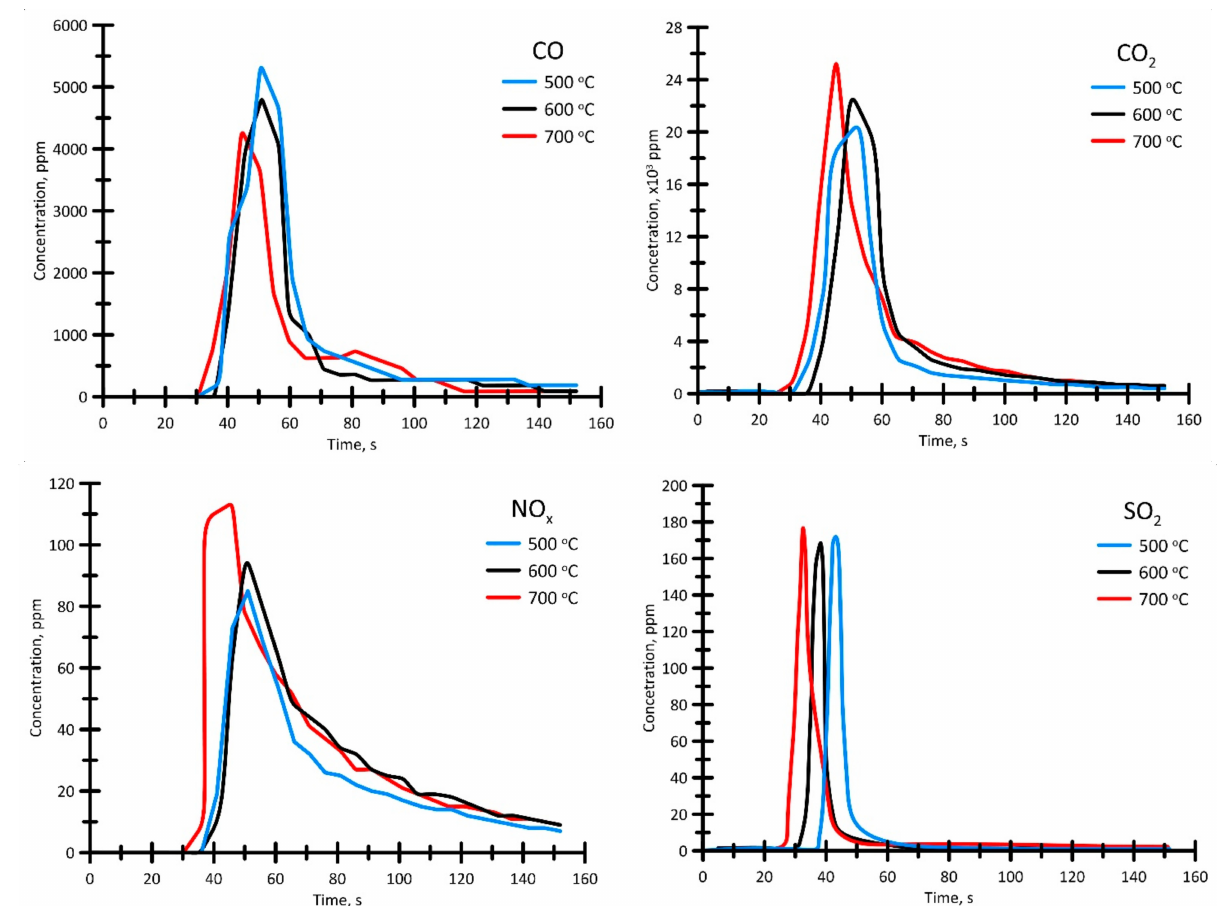
Figure 14. Concentration profiles of the release of gas-phase compounds CO, CO 2 , NO x , and SO 2 formed in the combustion of liquid hydrocarbon droplets at T g = 500–700 ◦